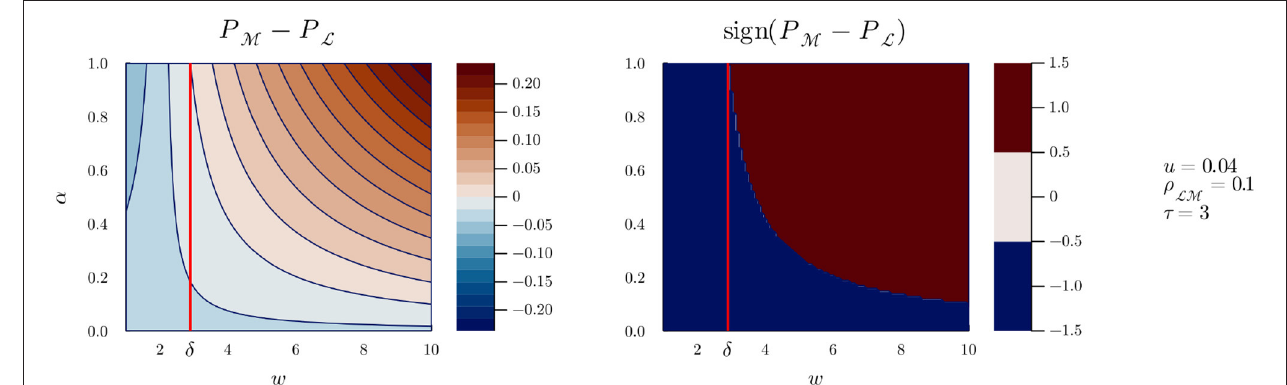
FIGURE 3 | g ( α , w ) for u = 0.04, ρ LM = 0.1, and τ = 3.